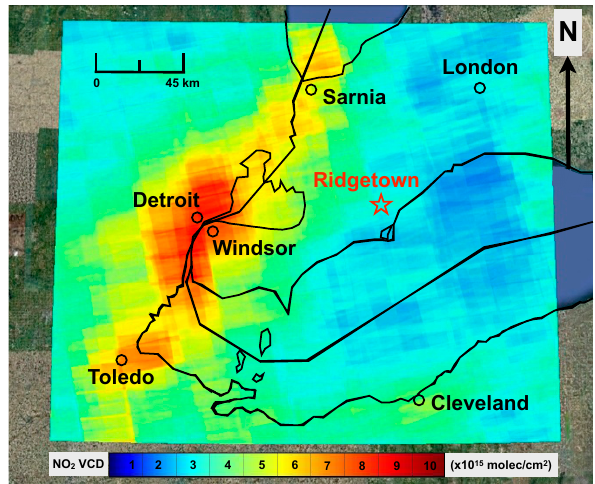
Fig. 11. Averaged OMI tropospheric NO 2 VCDs for the intensive field study period (20 June–10 July 2007) in southwestern Ontario. Ridgetown supersite is